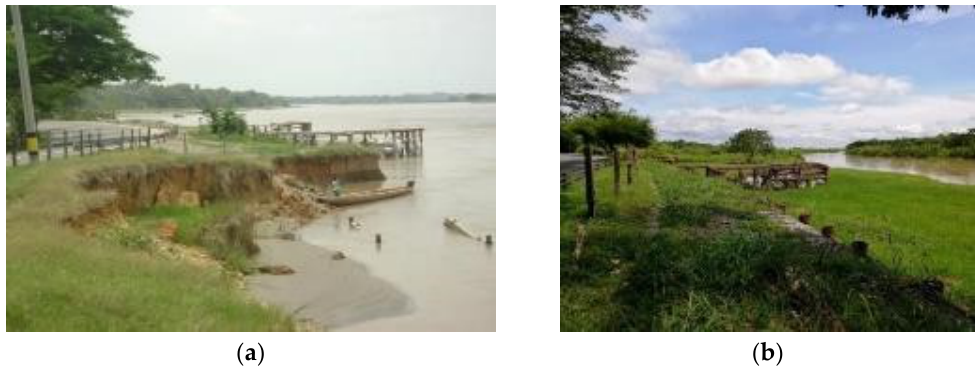
Figure 22. Cauca River, Guarumo site: ( a ) sedimentation generated shortly after the installation of the